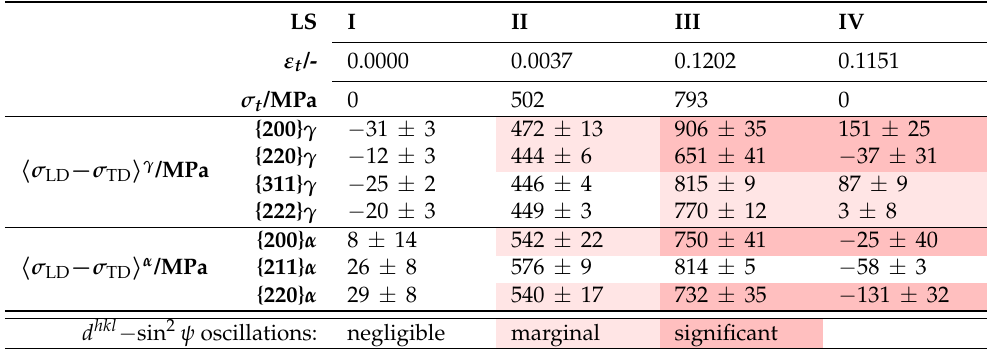
Table 5. Stresses in the austenitic phase (cid:104) σ LD − σ TD (cid:105) γ and ferritic phase (cid:104) σ LD − σ TD (cid:105) α of the DSS for different load states (LS) at the applied true stress σ t and the true strain ε t ; evaluation according to sin 2 ψ